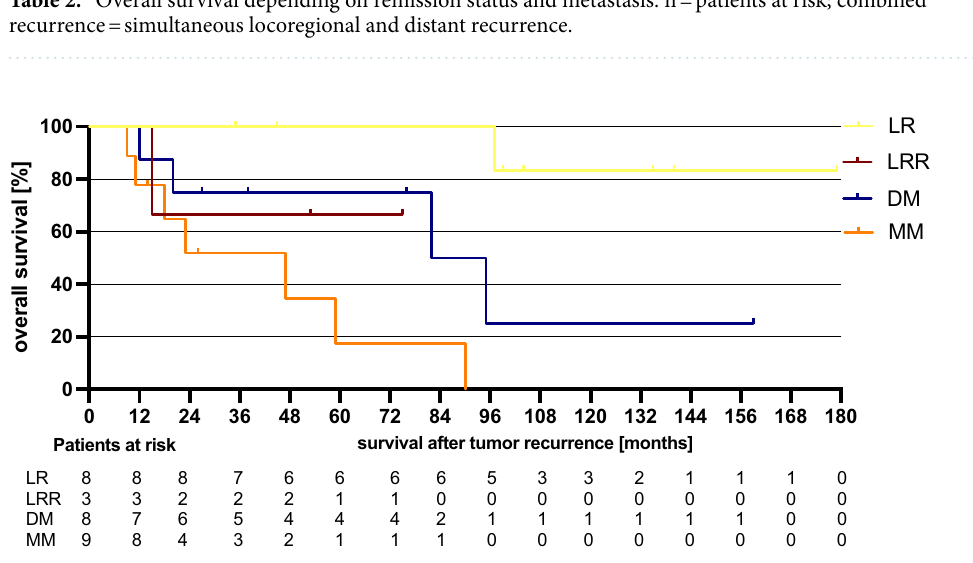
Figure 1. Survival in dependency of remission and recurrence. LR= local recurrence; LRR= locoregional recurrence; DM= distant metastasis; MM=multiple